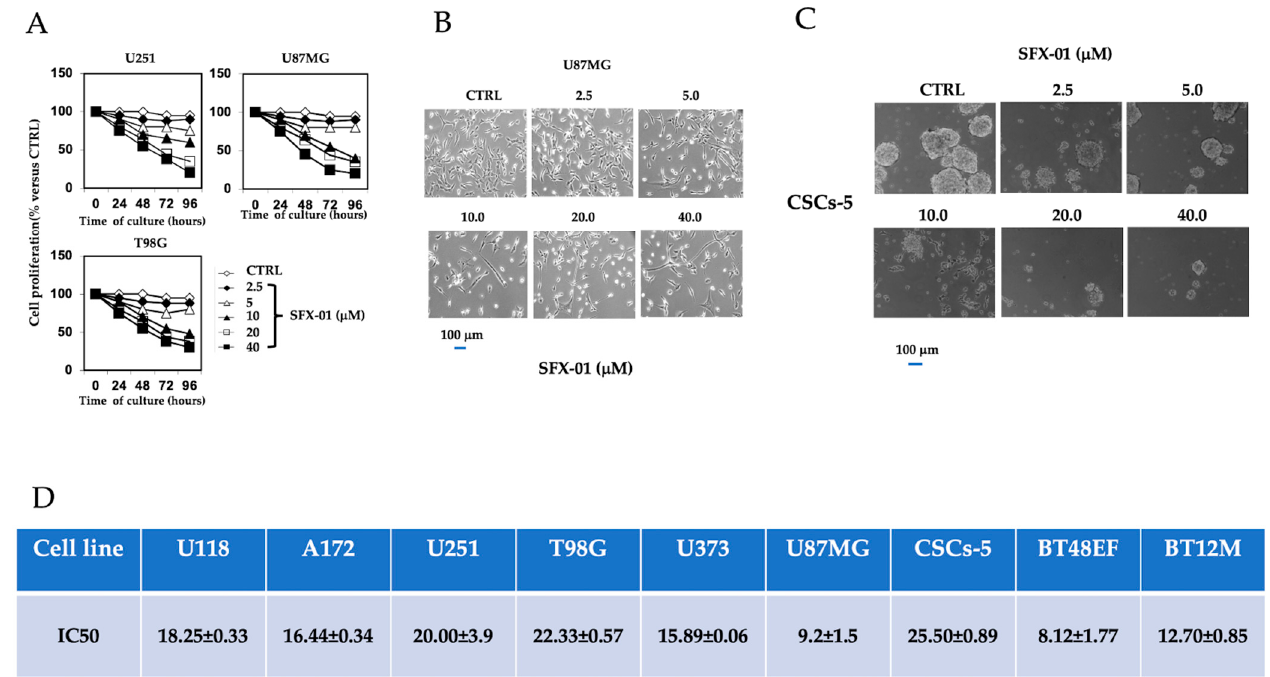
Figure 2. SFX-01 inhibited cell proliferation of GBM cell lines and GICs: ( A ) Growth rates at 24, 48, 72, and 96 h measured in U251, U87MG, and T98G cultured with different doses of SFX-01 (combined experiments for time and dose dependence). ( B ) Representative images of morphological changes caused by SFX-01 in U87MG cells treated for 48 h. SFX-01 caused the acquisition of cell extensions probably associated with the type I astrocytic phenotype. ( C ) Representative images of pre-formed GSC-5 neurospheres treated with different doses of SFX-01. The bar represents 50 µm. Cells were maintained and cultured for the experiments in serum-free DMEM/F12 medium mixture (1:1). ( D ) IC50 values (mean values +/ − standard deviation (SD) calculated by plotting the percentage of cells/colonies, normalized versus untreated controls, against each concentration of SFX-01 used as specified in the Materials and Methods section.